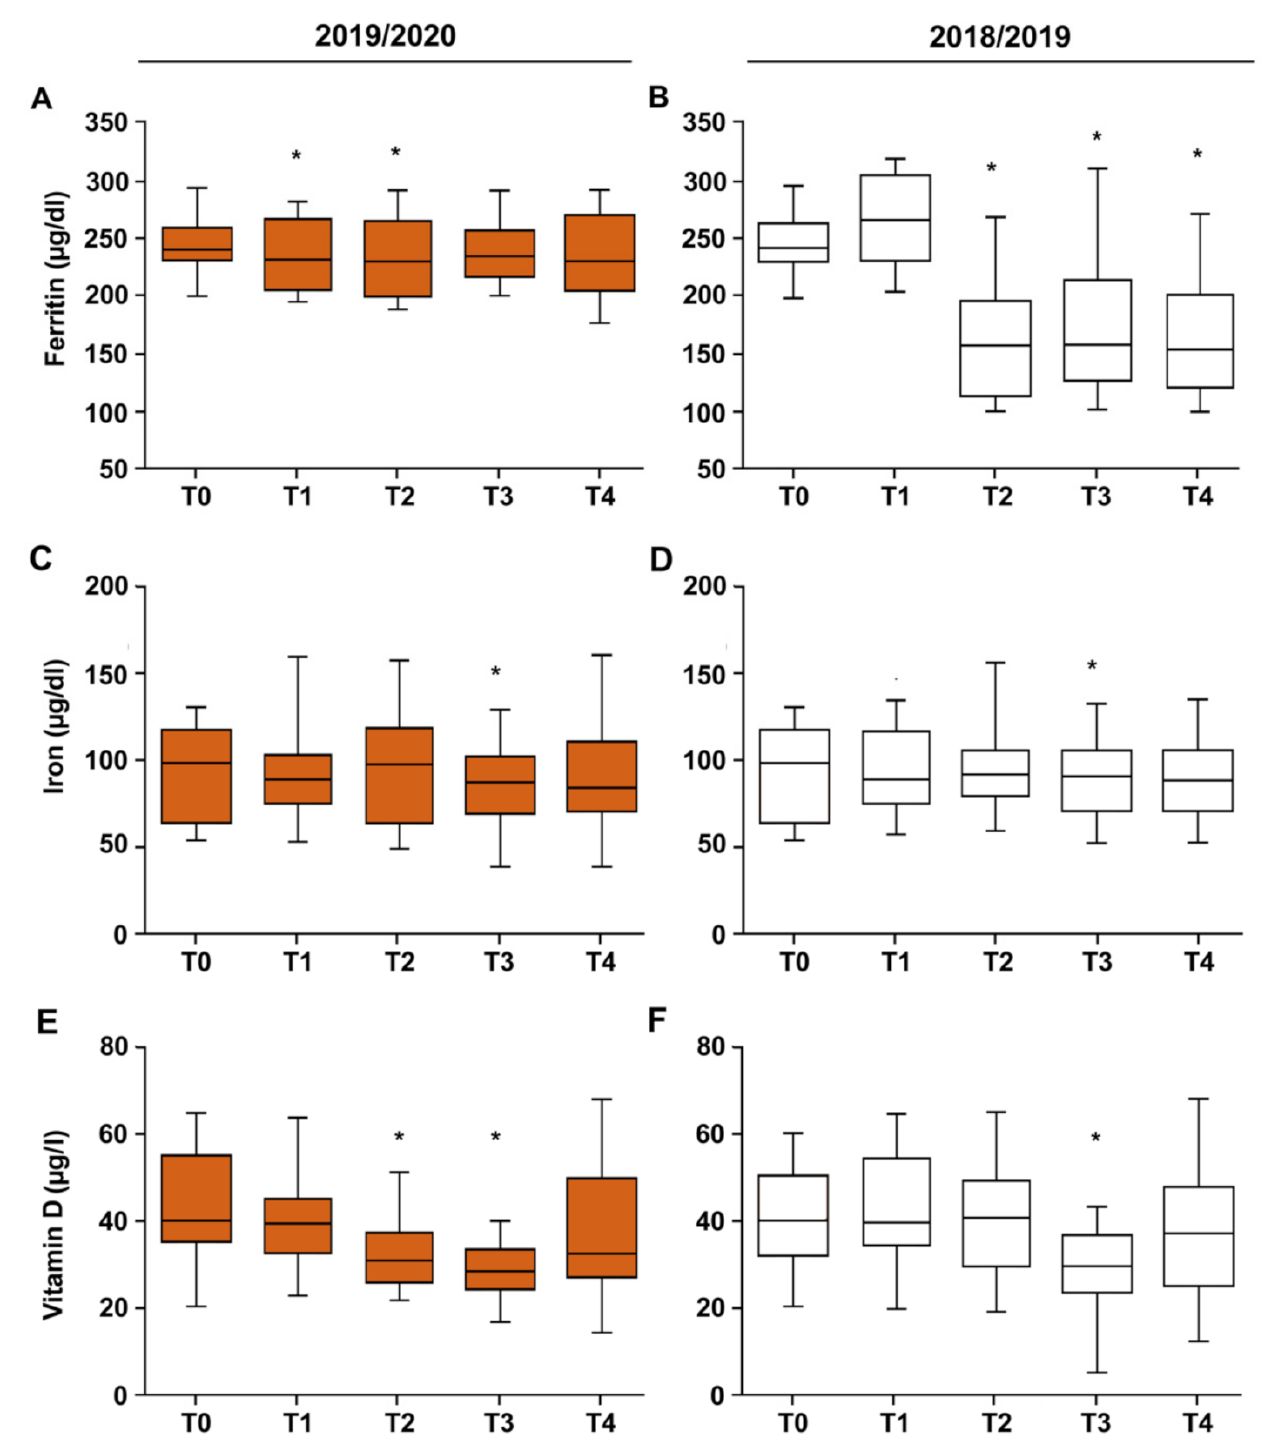
Figure 3. The effects of training on serum ferritin ( A , B ), iron ( C , D ), and vitamin D ( E , F ), concentration in football players during the 2018/2019 and 2019/2020 seasons. Box and whiskers representation of serum ferritin, iron, and vitamin D evaluated five times (T0, T1, T2, T3, and T4) during the seasons. In this representation, the central box covers the middle 50% of the data values, between the upper and lower quartiles. The bars extend out to the extremes, while the central line is at the median. p -values were obtained by Student’s paired t -test between each timepoint and T0. * p <